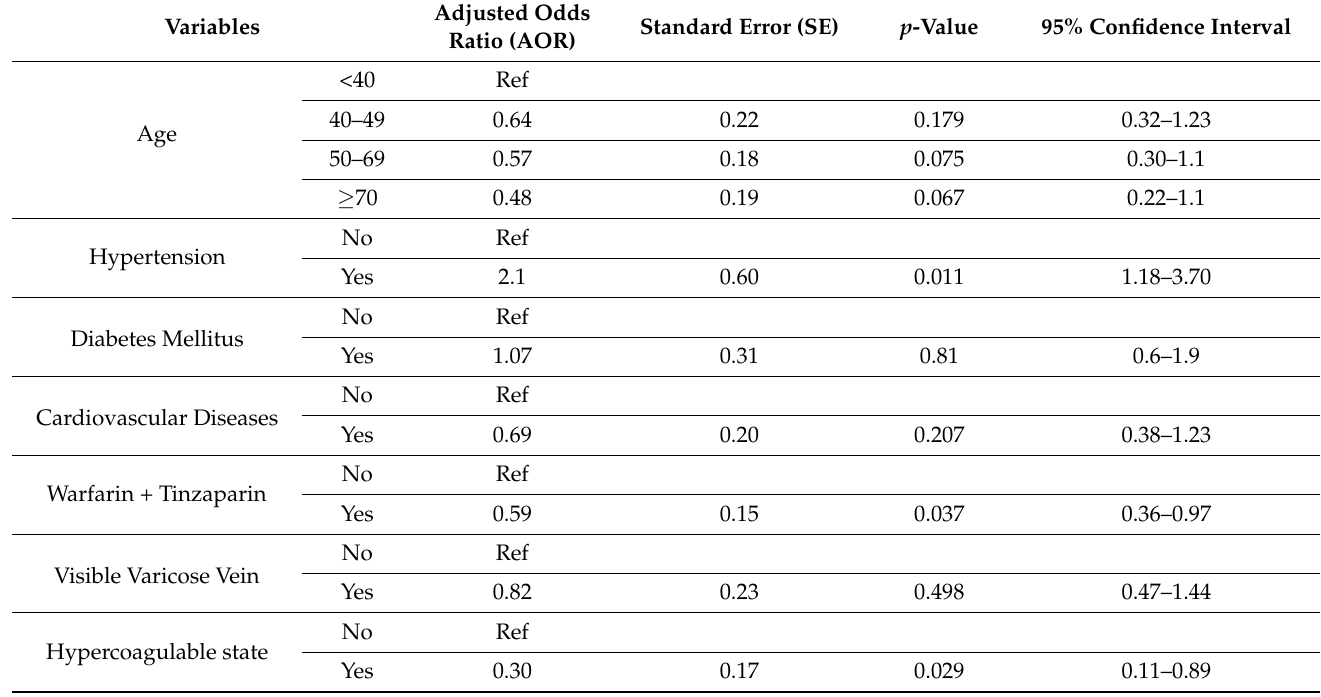
Table 4. Predictors of Hospital Length of Stay (LOS) among Patients with Venous Thromboembolism Using Multivariate Ordinal Logistic